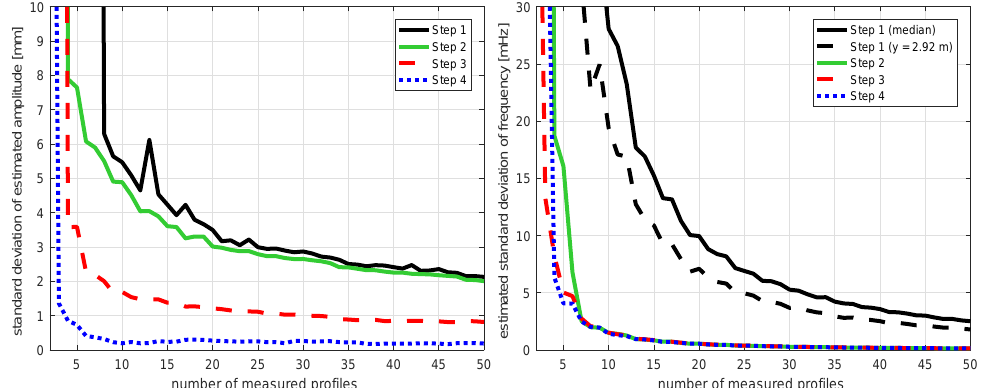
Figure 7. Results of set-up “length”: standard deviation of amplitude ( left ) and frequency ( right ). For reasons of clarity, the vertical axes are limited to 10 mm or 30 mHz, respectively, although larger values